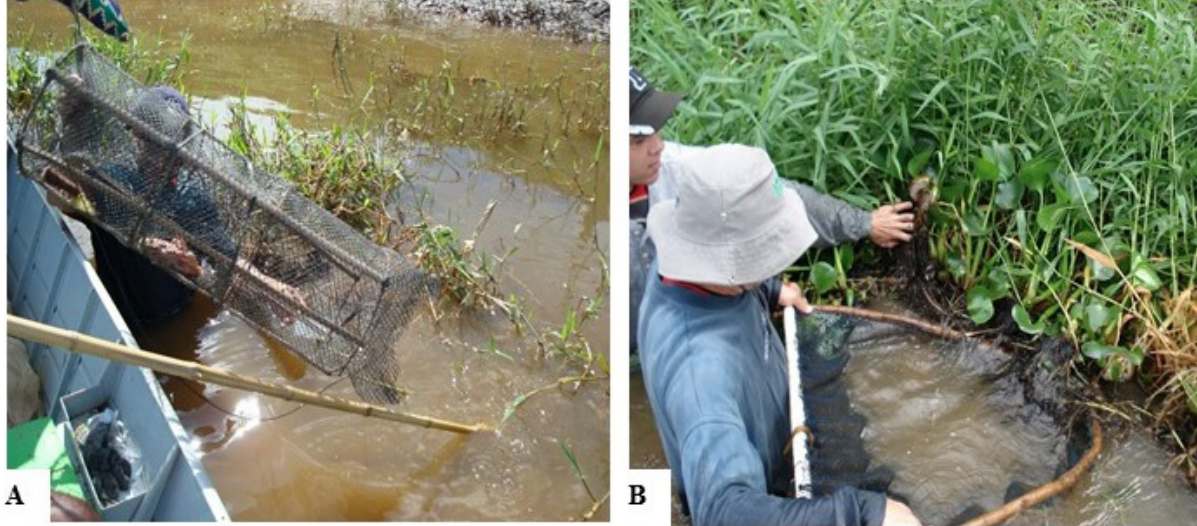
Figure 2. Capture methods. ( A ) Trap baited with cow bones. ( B) Sieve (0.5 m 2 , 5 mm mesh size). Photos: G.